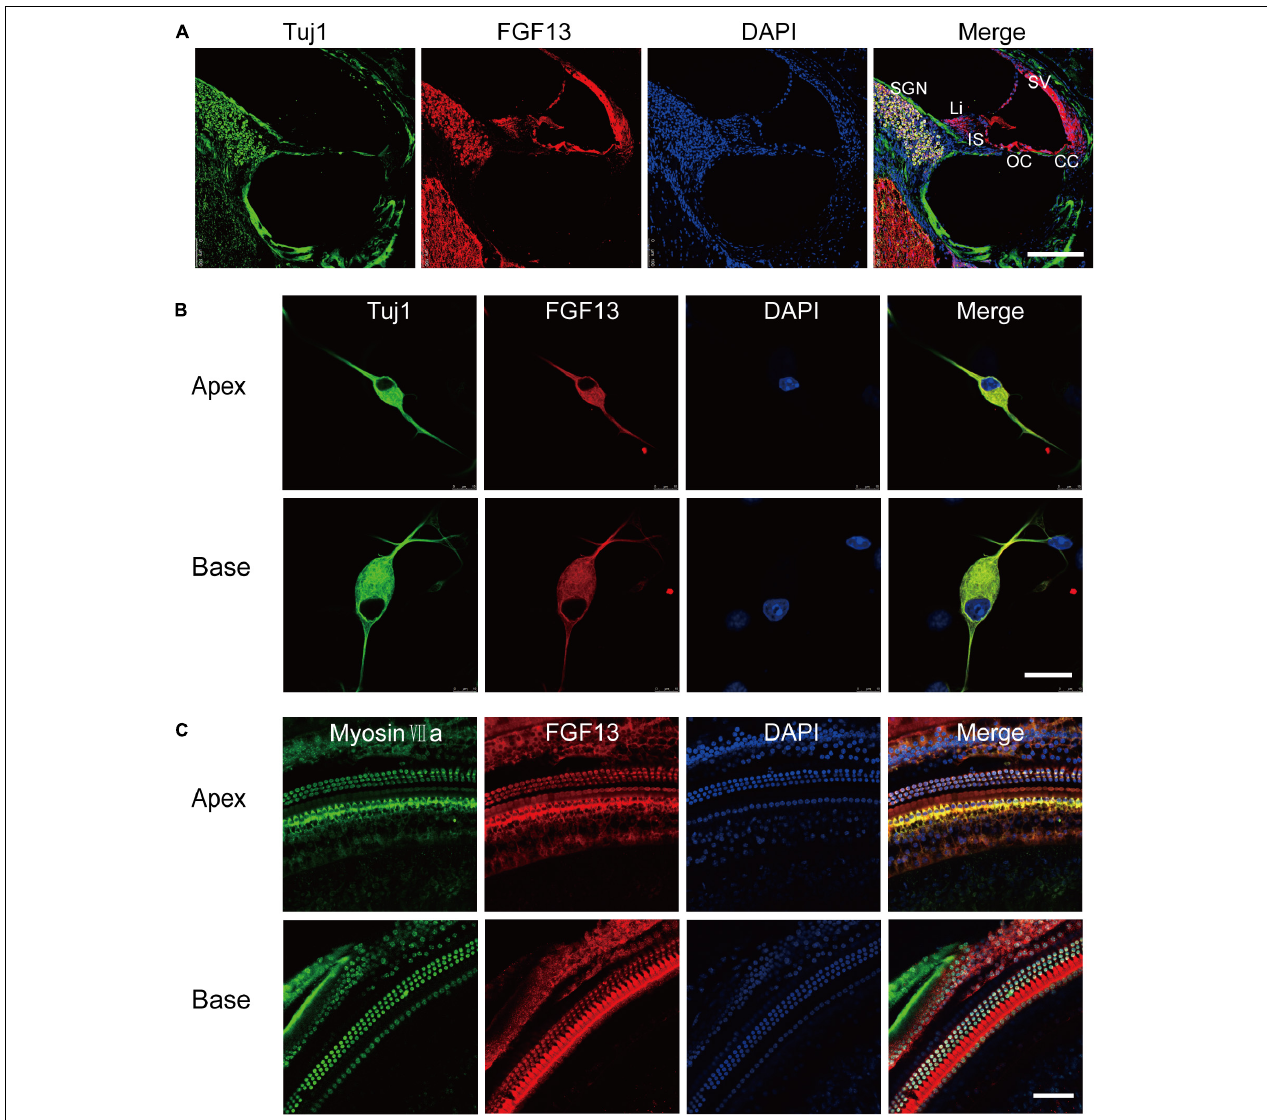
FIGURE 1 | FGF13 is highly expressed in SGNs and HCs of the cochlea. (A) Confocal images of cryosections from the base of the cochlea show immunodetection of FGF13 (red), Tuj1 (green), and DAPI (blue). Tuj1 was used as a neuron marker. SV, stria vascularis; OC, organ of Corti; CC, Claudius’s cells; IS, inner sulcus; Li, spiral limbus; SGN, spiral ganglion neurons; Scale bar = 200 µ m. (B) Immunofluorescence staining of cultured SGNs at a cellular level. Scale bar = 20 µ m. (C) Confocal whole-mount images of FGF13 in hair cells. Myosin VIIa (green) served as a hair cell marker. Scale bar = 50 µ